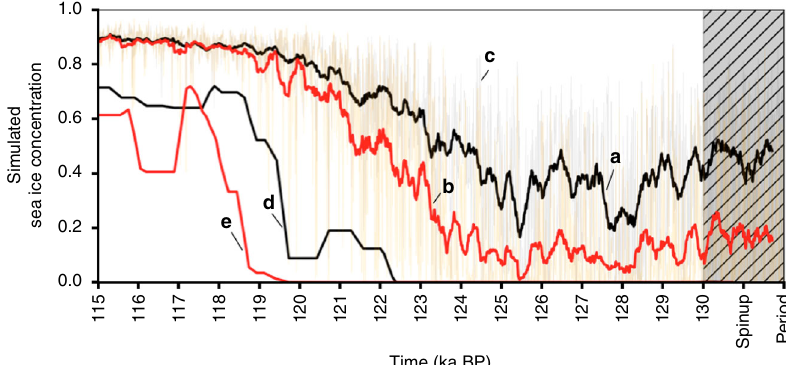
Fig. 9 Transient simulation of the 130 – 115 ka time interval, with site location of Core PS2138-2 in black ( a ) and the location shifted by one model grid point to the south in red ( b ). Semi-transparant time series ( c ) show the yearly simulation output, while the thick lines a and b indicate a 30-year running average, and a 100-year minimum of the 30-year running average. The last of these time series (running minimum) d and e demonstrates the signal that might realistically be captured by the biomarker proxy records. That means, at the location of Core PS2138-2 ( d ) sea ice concentrations of < 10% might have occasionally occurred at 120